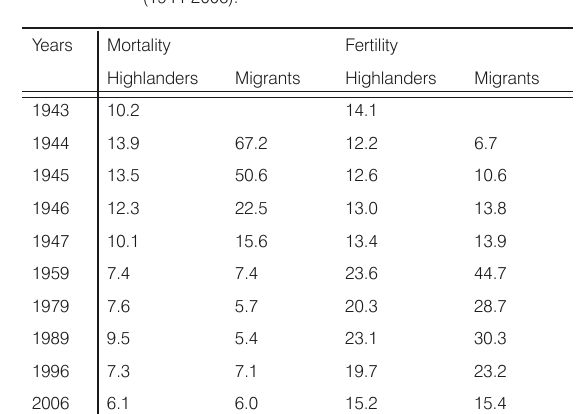
Table 1. Mortality and Fertility Rates per 1,000 among Highlanders and Migrants before Migration (1943), and After Migration